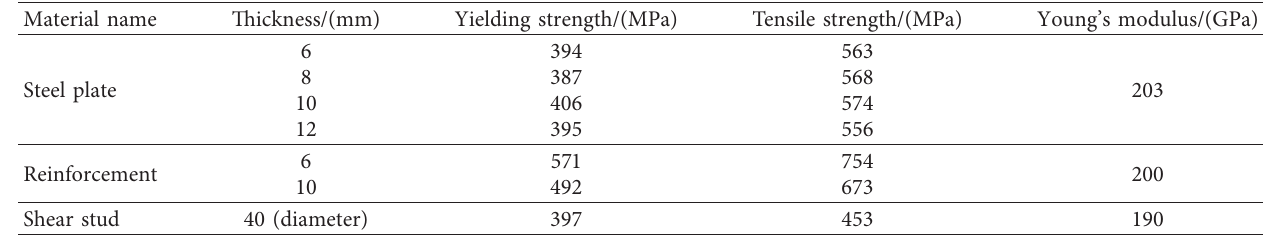
Table 3: Material properties of